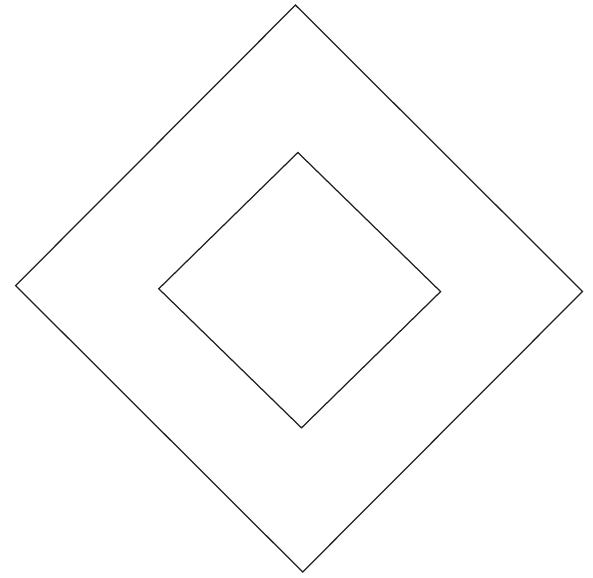
Figure 3: Source shape (target shape).